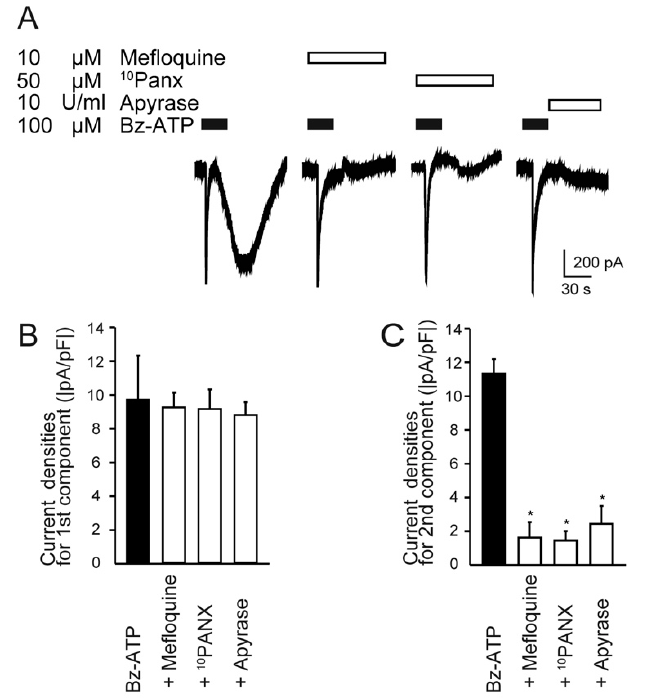
Figure 5. Pharmacological properties of Bz-ATP-induced biphasic inward current. ( A ) Representative traces of Bz-ATP-induced current (upper black boxes; 100 µ M) with or without PANX1 channel inhibitors (10 µ M mefloquine and 50 µ M 10 Panx), and ATP-degrading enzyme (10 U/mL apyrase) (each upper open box). ( B , C ) Summary bar graphs showing the current densities of the first ( B ) and second components ( C ) of the Bz-ATP-induced biphasic inward currents. Each bar denotes the mean ± SD of five experiments. Statistically significant differences between columns are indicated by asterisks. * p < 0.05.